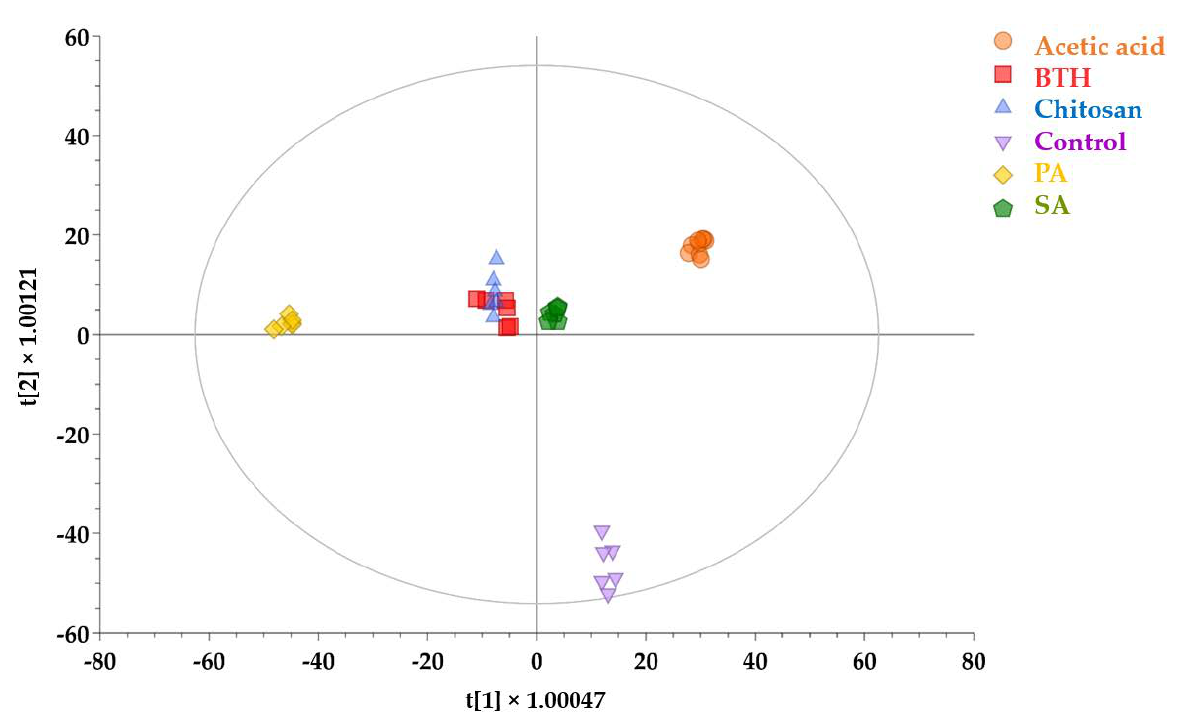
Figure 2. Supervised discrimination of the metabolomics profile in tomato leaves following the treatment with different elicitors. The score plot in figure was produced by orthogonal projection to latent structures discriminant analysis (OPLS-DA) modeling according to first and second latent vectors, t[1] and t[2], respectively. The model correlation with the dataset was R 2 Y = 0.99, whereas prediction ability was Q 2 Y =